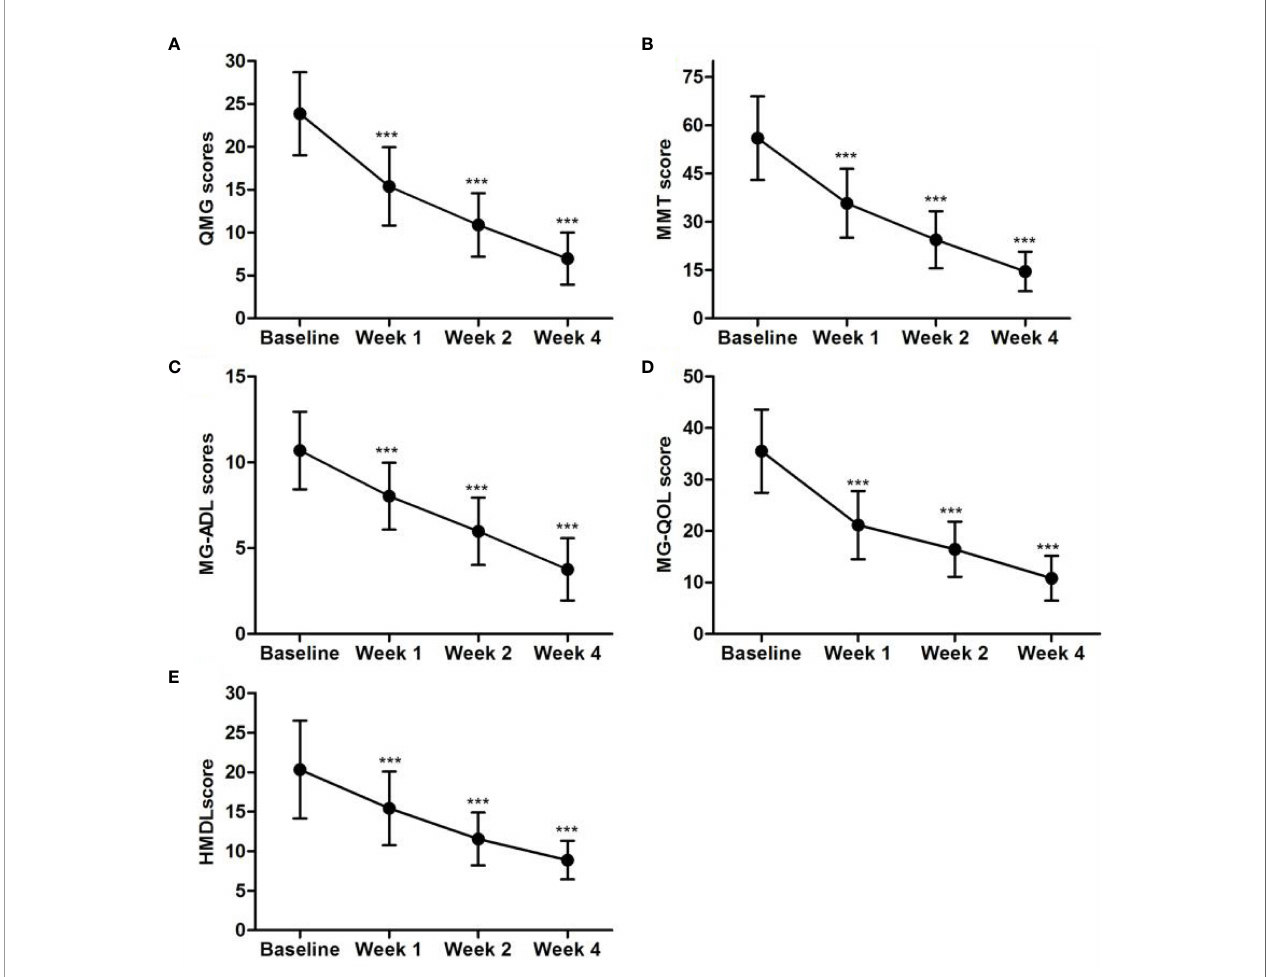
FIGURE 2 | LPE improved clinical symptoms in generalized MG patients. The scores of QMG, MMT, MG-ADL, MG-QOL, and HMDL declined signi fi cantly 4 weeks after LPE therapy (n=276, ***p < 0.001). (A) QMG scores of MG patients of baseline, week 1, week 2, and week 4 after the fi rst replacement of LPE therapy. (B) MMT scores of MG patients of baseline, week 1, week 2, and week 4 after the fi rst replacement of LPE therapy. (C) MG-ADL scores of MG patients of baseline, week 1, week 2, and week 4 after the fi rst replacement of LPE therapy. (D) MG-QOL scores of MG patients of baseline, week 1, week 2, and week 4 after the fi rst replacement of LPE therapy. (E) HMDL scores of MG patients of baseline, week 1, week 2, and week 4 after the fi rst replacement of LPE therapy.Note: LPE, lymphoplasma exchange; MG, myasthenia gravis; QMG, Quantitative Myasthenia Gravis; MMT, Myasthenia Gravis Speci fi c Manual Muscle Testing; MG-ADL, Myasthenia Gravis Speci fi c Activities of Daily Living scale; MG-QOL, myasthenia gravis quality of life; HMDL, Hamilton Depression